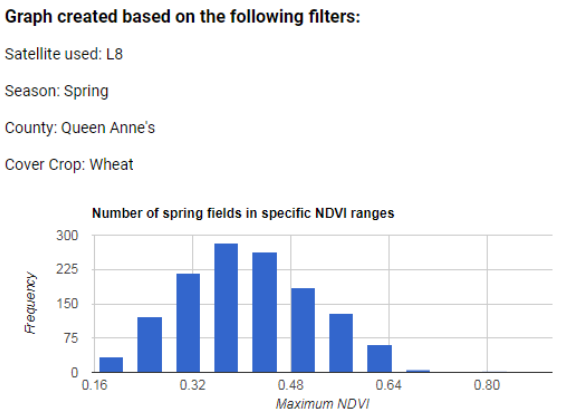
Figure 2. CCROP output histogram displaying number of fields versus NDVI for wheat fields in Queen Anne’s County.